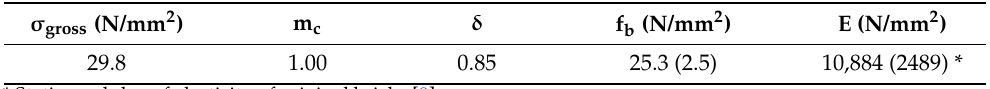
Table 2. Mean values of compressive strength and static modulus of elasticity of original old bricks. σ gross (N/mm 2